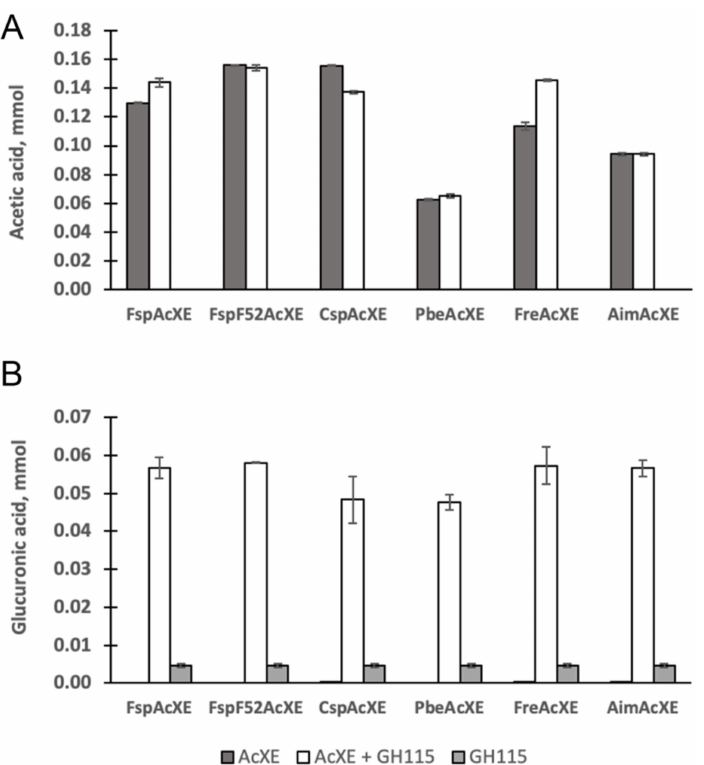
Figure 3. Release of acetic acid ( A ) and glucuronic acid ( B ) from acetylated Eucalyptus wood (AcXOS). n = 3; error bars correspond to standard